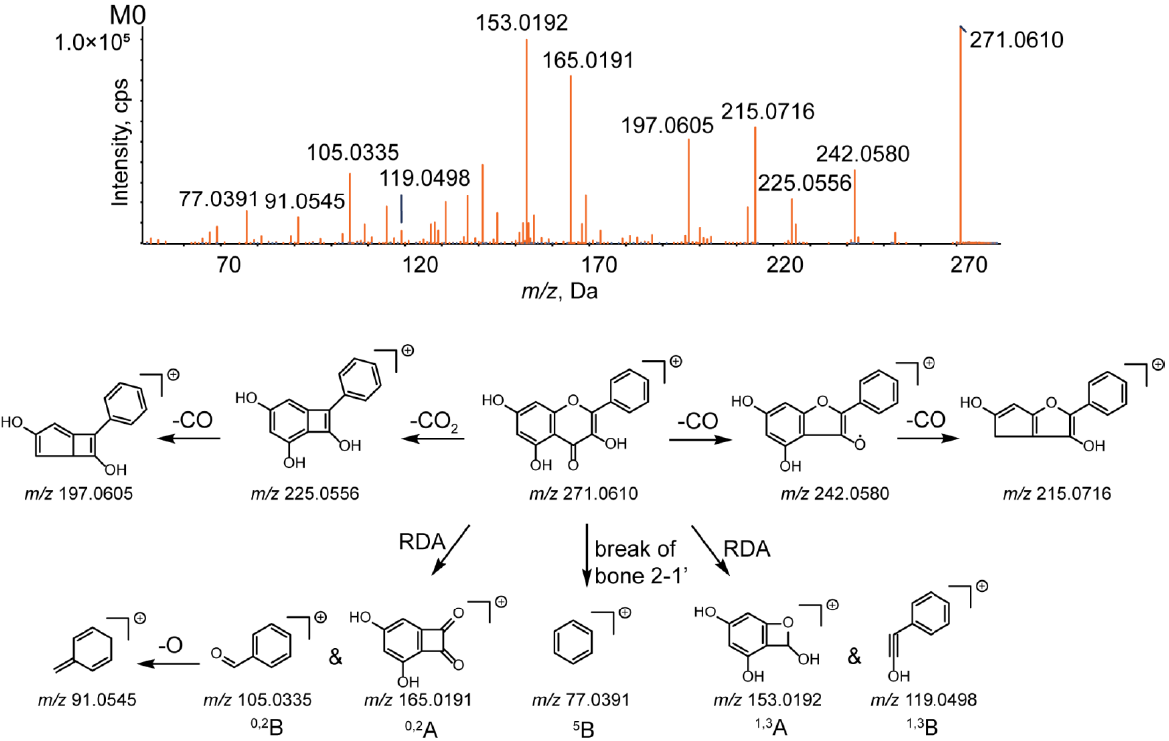
Metabolites 2022 , 12 , x FOR PEER REVIEW Figure 4. MS/MS spectrum of galangin and its proposed fragmentation pathways. Figure 4. MS/MS spectrum of galangin and its proposed fragmentation pathways.